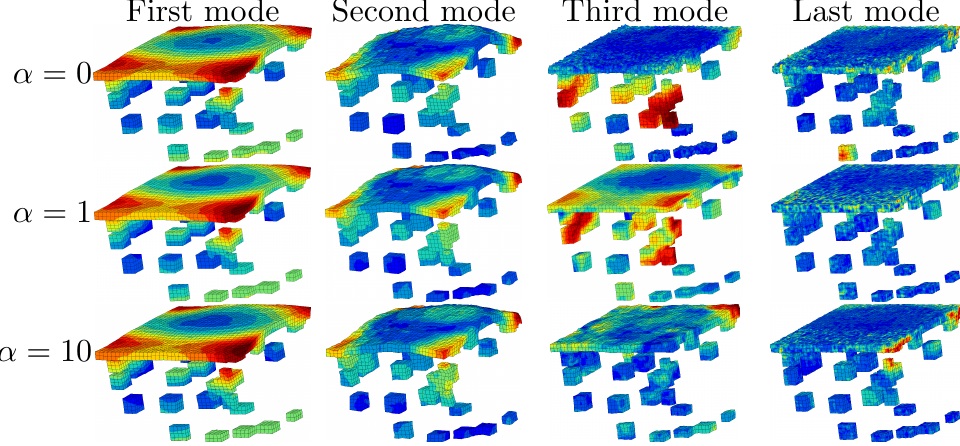
+ u 2 + u 2 u 2 ) for each DEPOD mode depending on α 2 3 1 (cid:113)